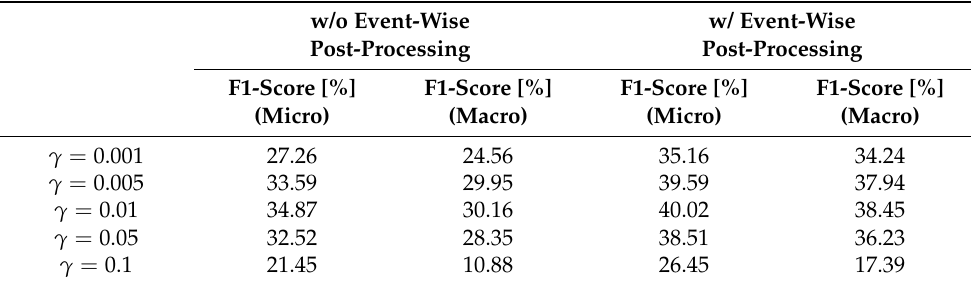
Table 4. Comparison results with various thresholds of singular values for calculating the pseudo-